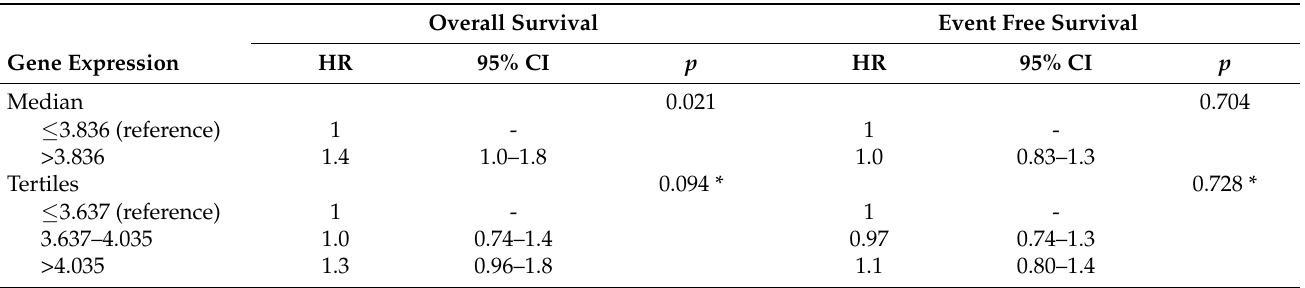
Table 5. Survival of the whole cohort of patients with NB in relation to MAPK3 gene-expression values, evaluated by the multivariable Cox regression